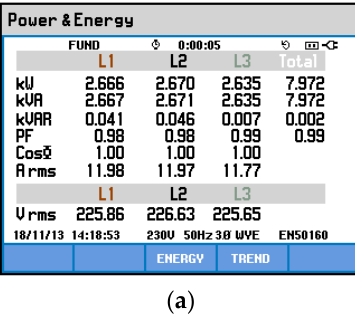
Figure 42. Case 5 - ZSS and three-wire ShAPF operating with unbalanced loads: ( a ) source power; ( b ) voltage and current waveforms in phase S .